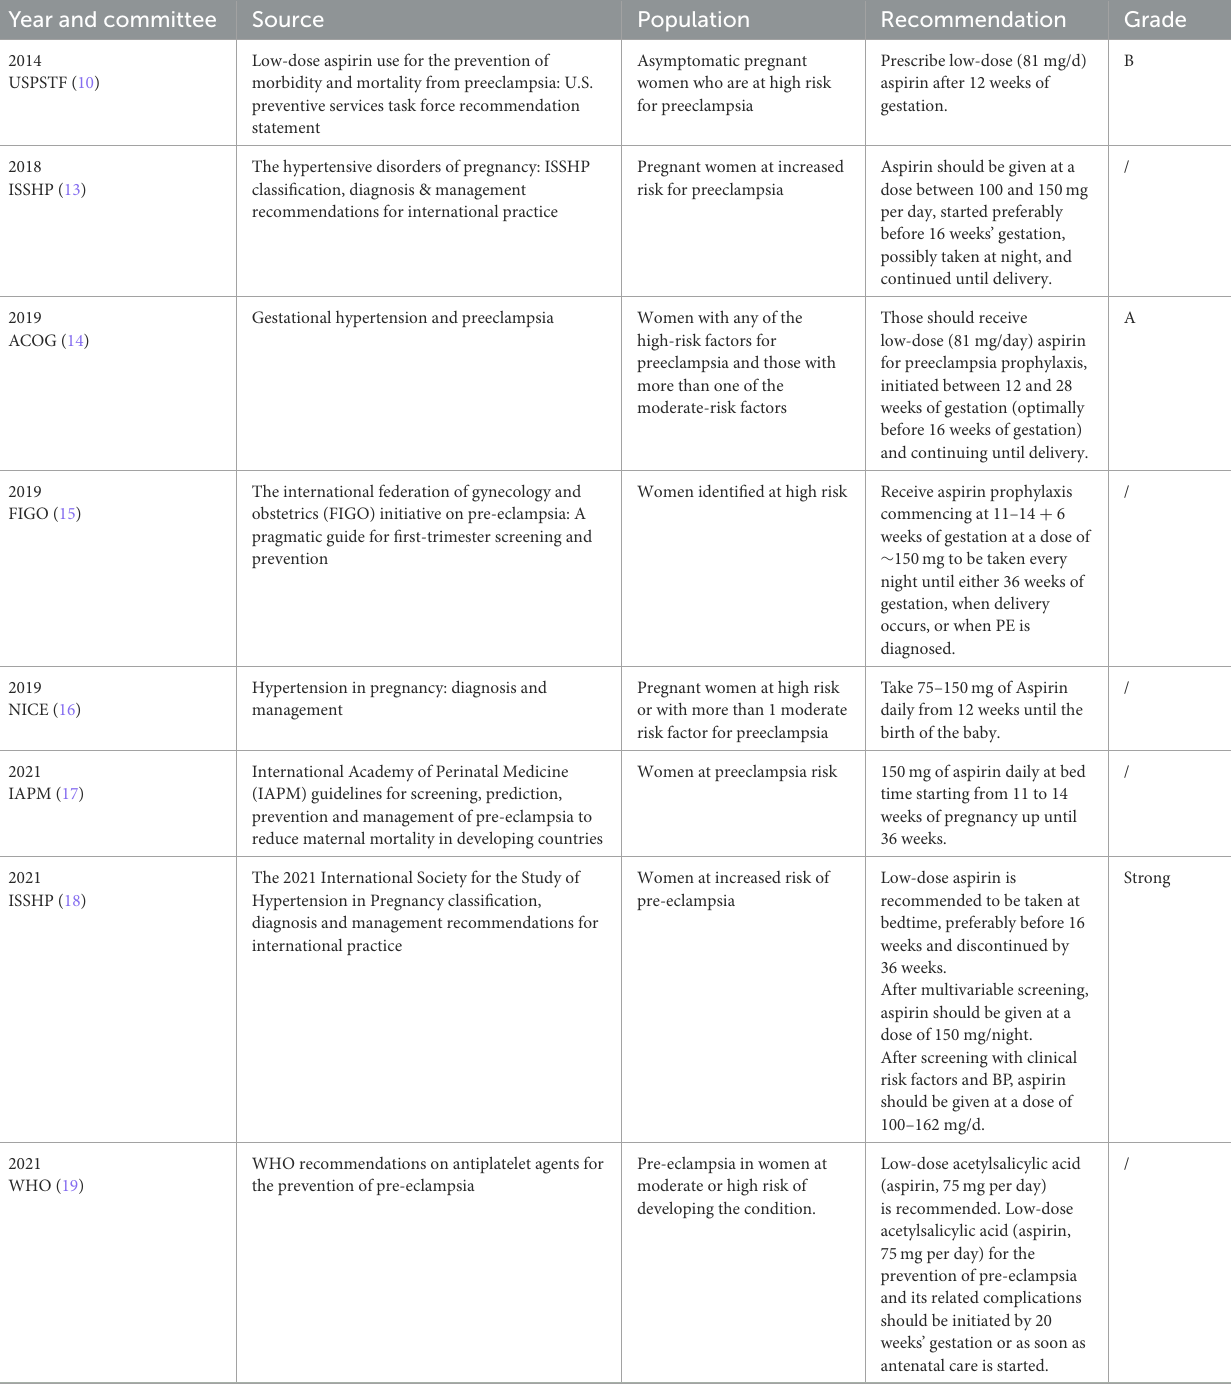
TABLE 1 Aspirin criteria and doses for prevention of